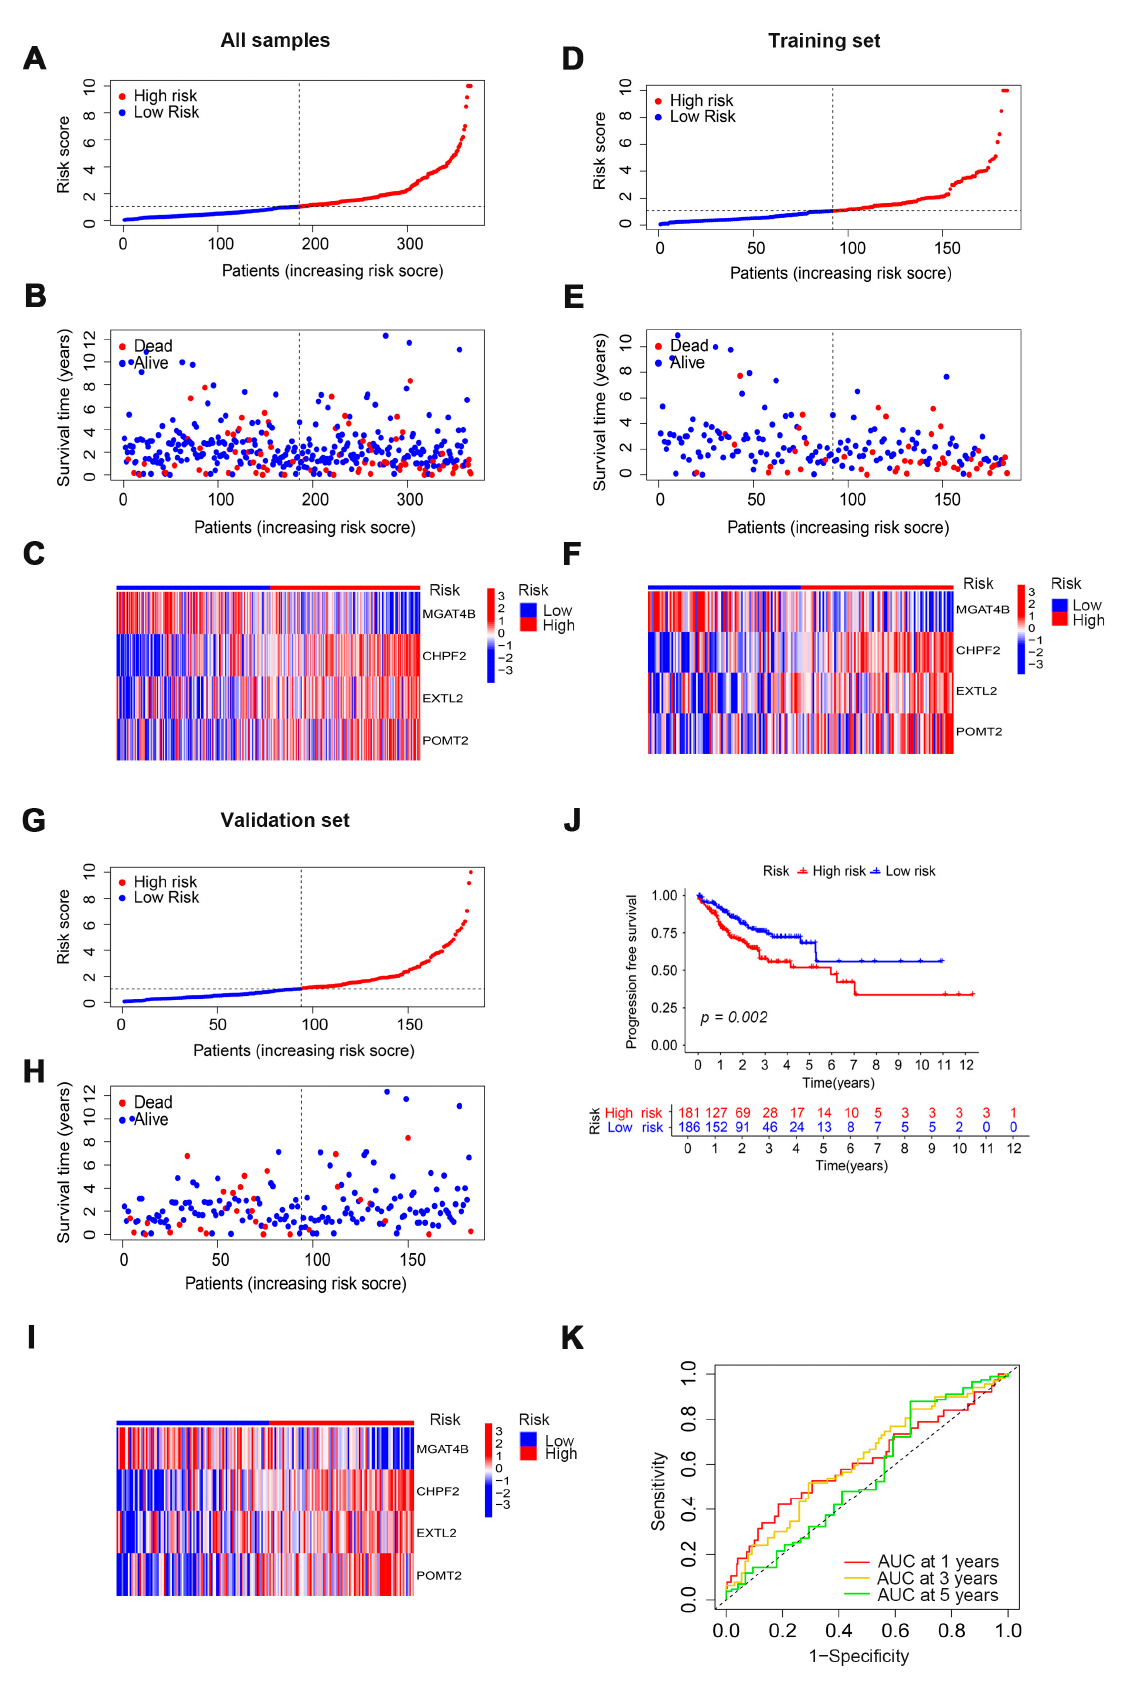
Figure 3. Validation of the prognostic predictive ability of cuproptosis-related